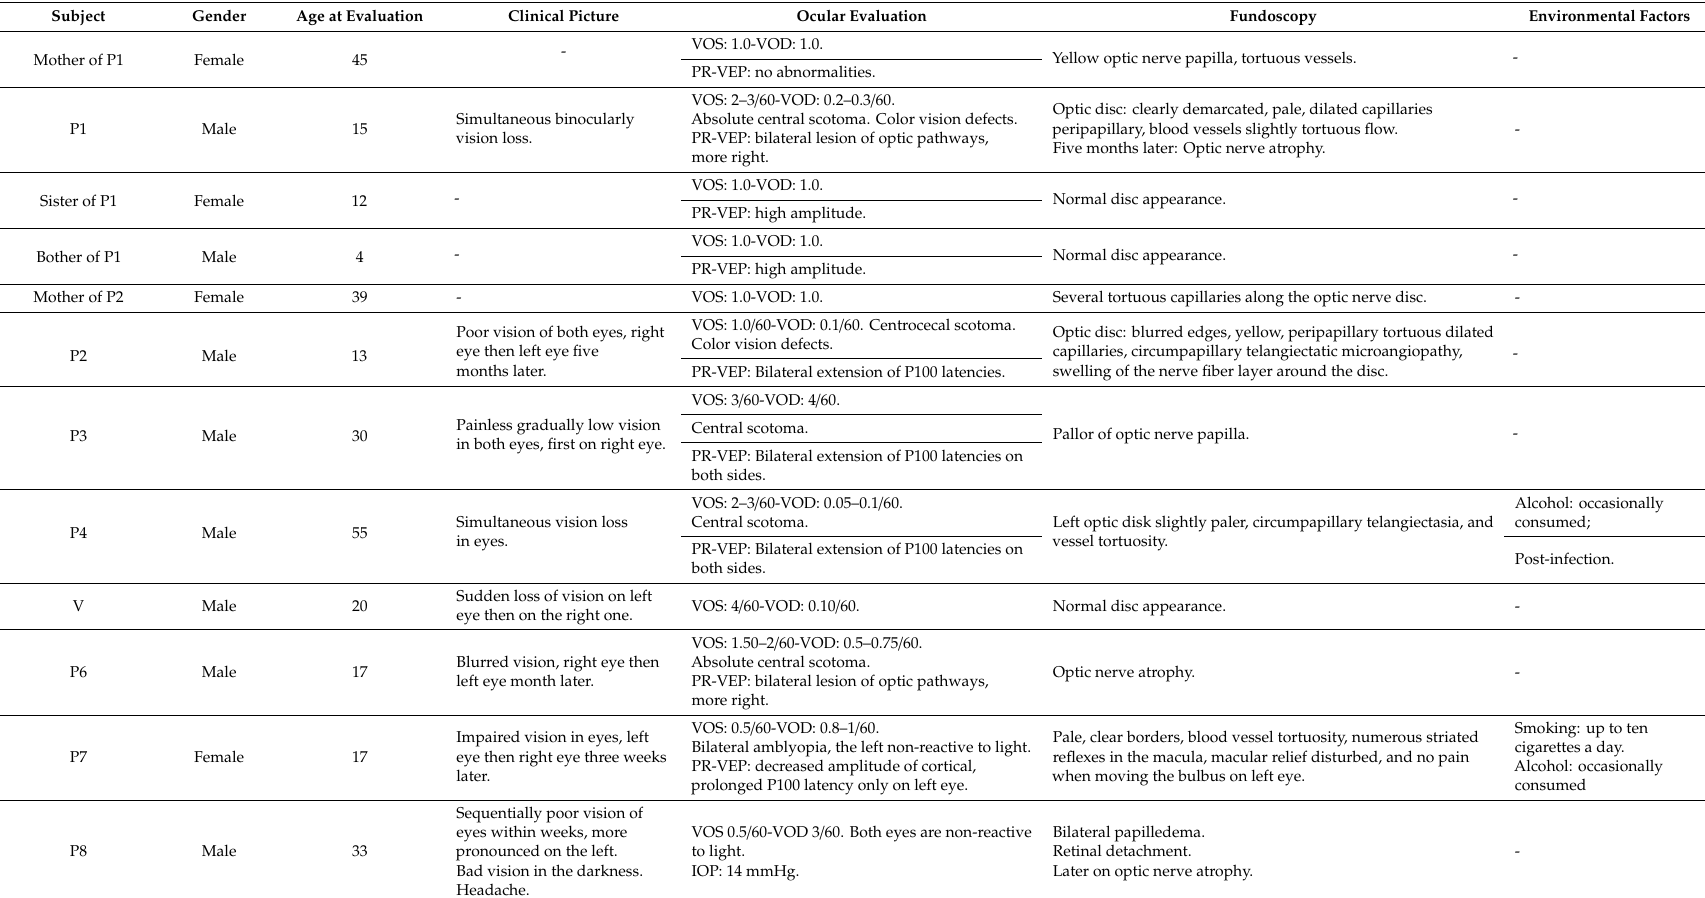
Table 4. Ophthalmic evaluation of LHON in Serbian